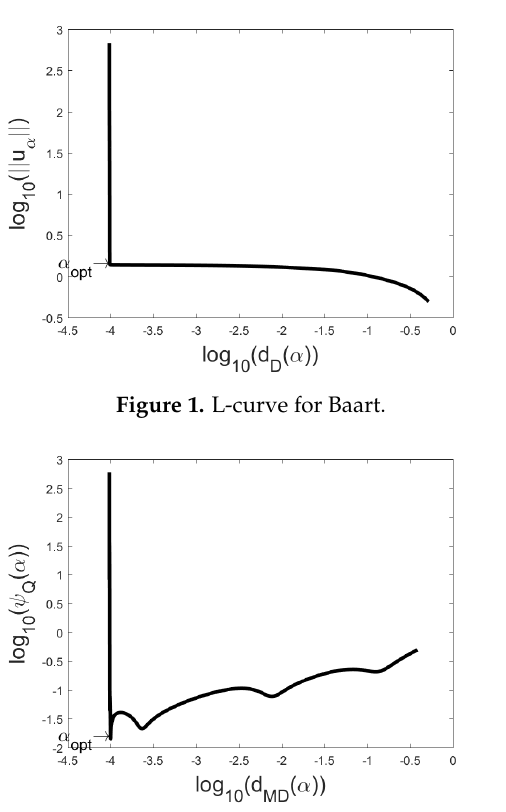
Figure 2. Q-curve for